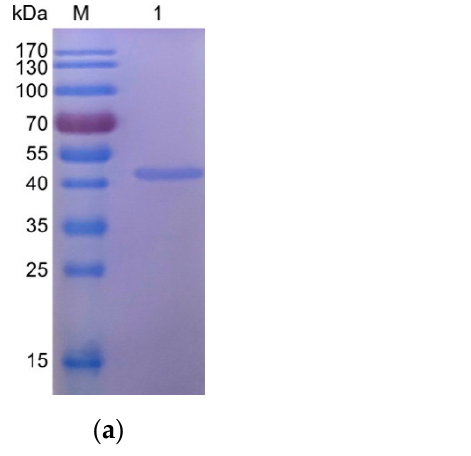
Figure 1. ( a ) SDS-PAGE gel of purified recombinant TgPSA1 (Line 1). Line M: molecular weight (MW) marker proteins. ( b ) Western blot analysis of recombinant TgPSA1. rTgPSA1 detected by serum from T. gondii -infected rats (Line 1) and healthy rats (Line 2). Line M: MW marker proteins. ( c ) Western blot analysis of native TgPSA1. Total soluble protein of T. gondii tachyzoites detected by sera from rTgPSA1-immunized rats (Line 1) and healthy rats (Line 2). Line M: MW marker proteins.